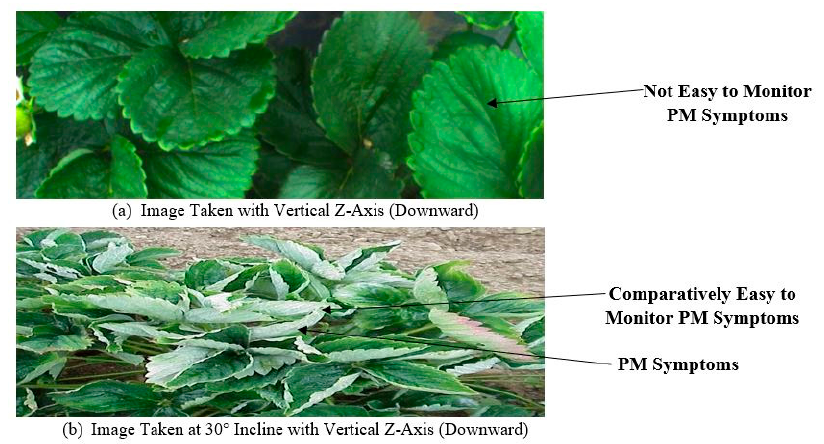
Figure 4. Images captured at two different camera angles prior to study to test acquisition quality ( a ) image taken with vertical z-axis (downward) ( b ) image taken at 30° incline with vertical z-axis (downward).